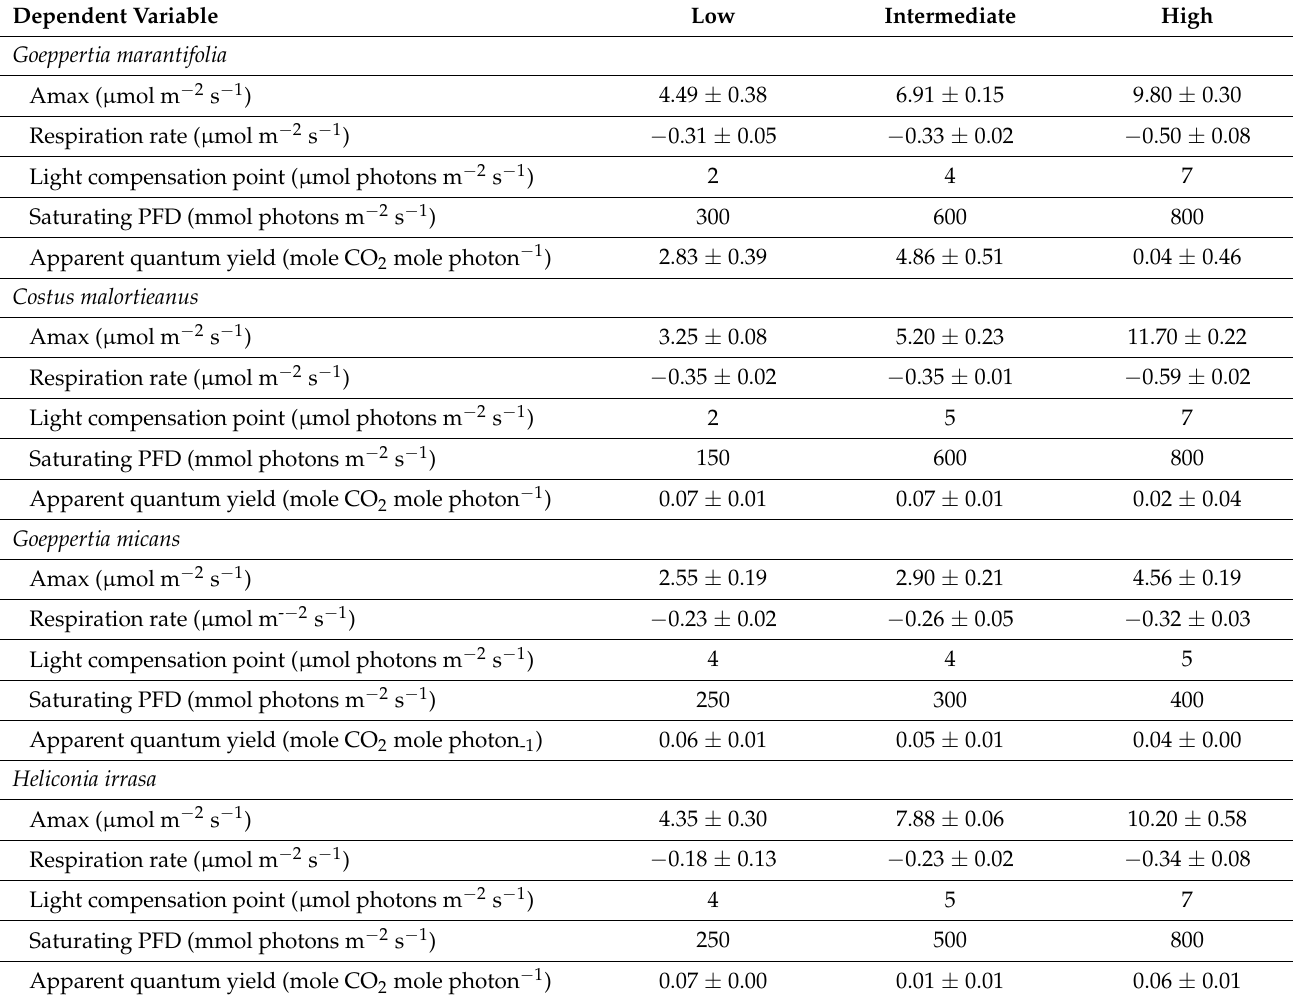
Table 2. Photosynthetic parameters of the light response curve of photosynthesis for four understory herbs grown in varying light conditions (low, intermediate, high). Measurements were made at leaf temperature between 25 to 26 ◦ C and leaf to air vapor pressure deficits of <1.0 MPa. Values are averages of 2–3 leaves from each of 2–3 different individuals ± 1